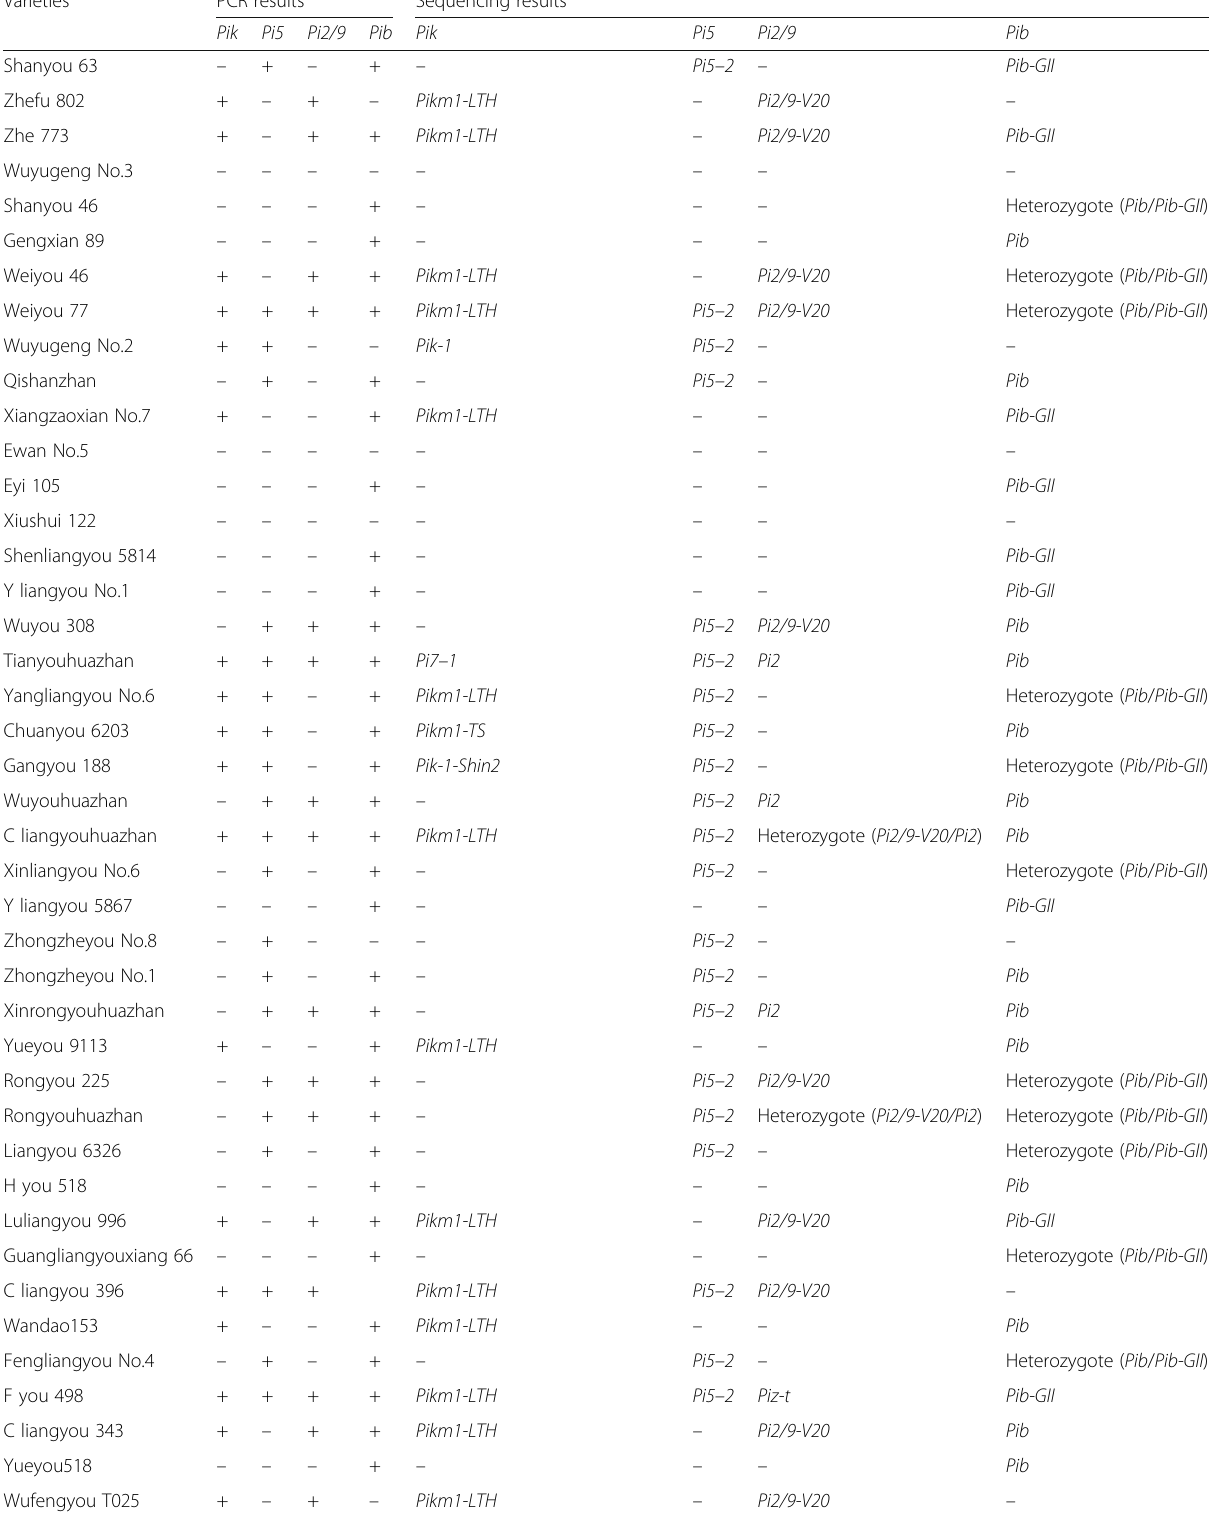
Table 1 The PCR and sequencing results of different haplotypes of 4 R -gene loci in 54 rice varieties. PCR: Polymerase chain reaction; +: PCR positive; − : PCR negative; LTH: Lijiangxintuanheigu